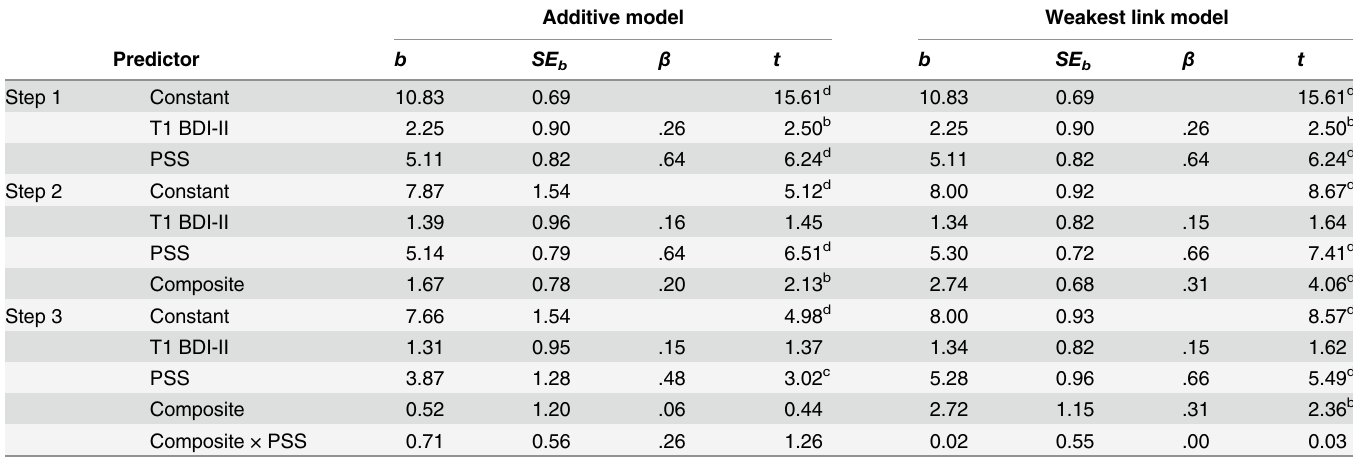
Table 2. Hierarchical regression models testing integrative